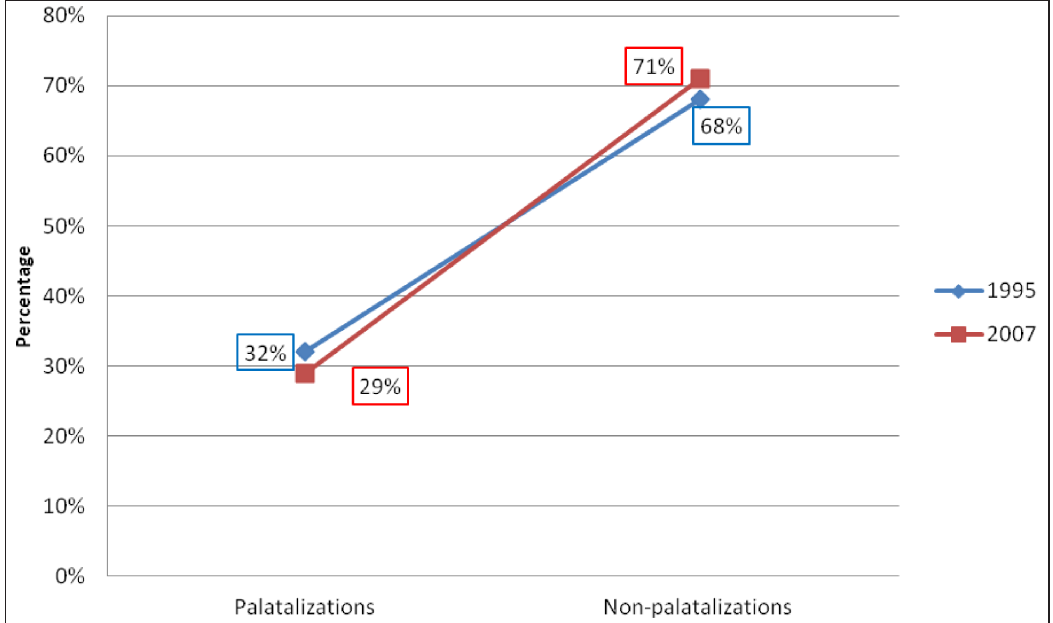
Figure 1: Overall distribution of the realizations of tokens of palatalization of /ti/, /di/ in UP 1995 and 2007